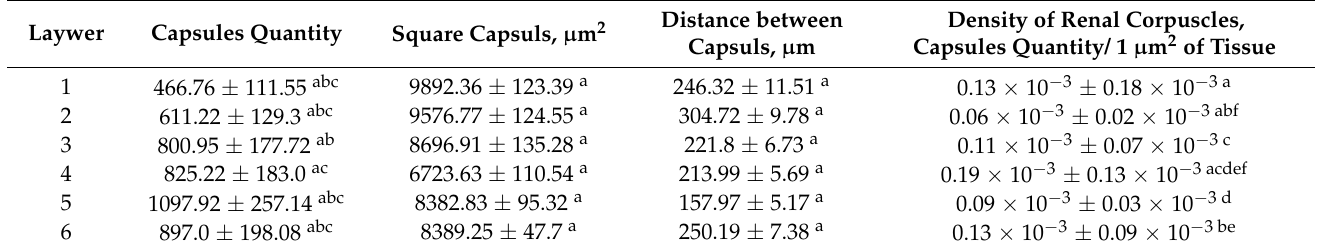
Table 1. Morphometric parameters of the structural elements of the mesonephros of P. senegalus